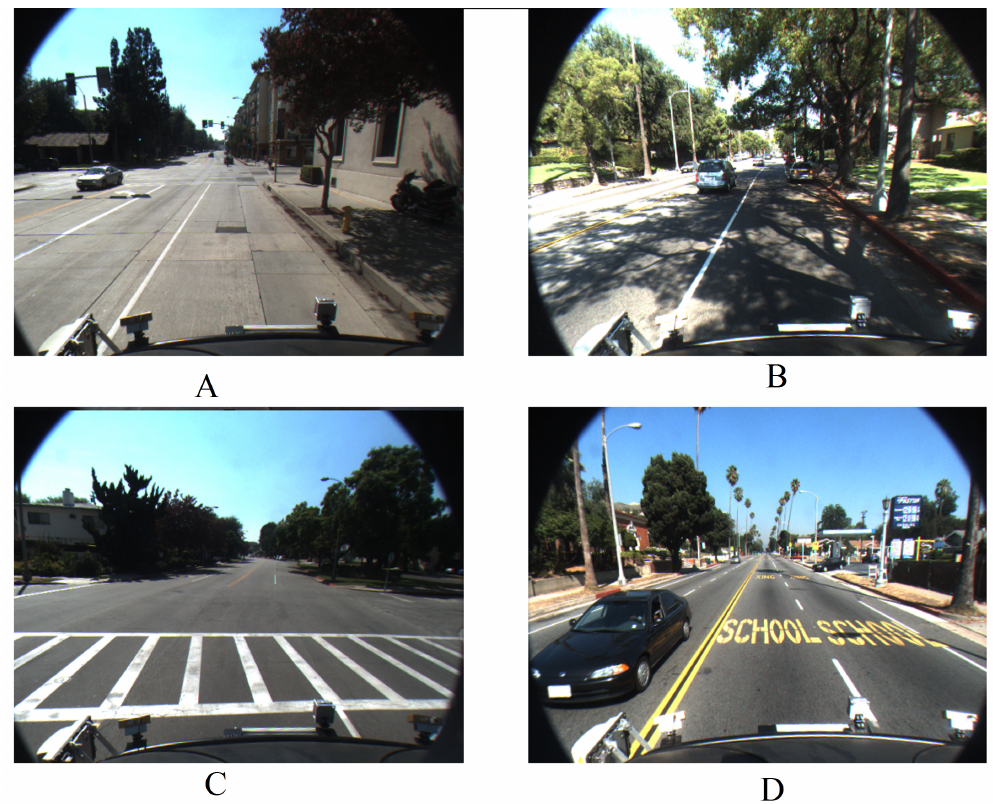
Figure 1. Example cases where extracting lane markings is challenging ( A ) patched road; ( B ) Shadow; ( C ) cross walk; ( D ) road markings (adopted from